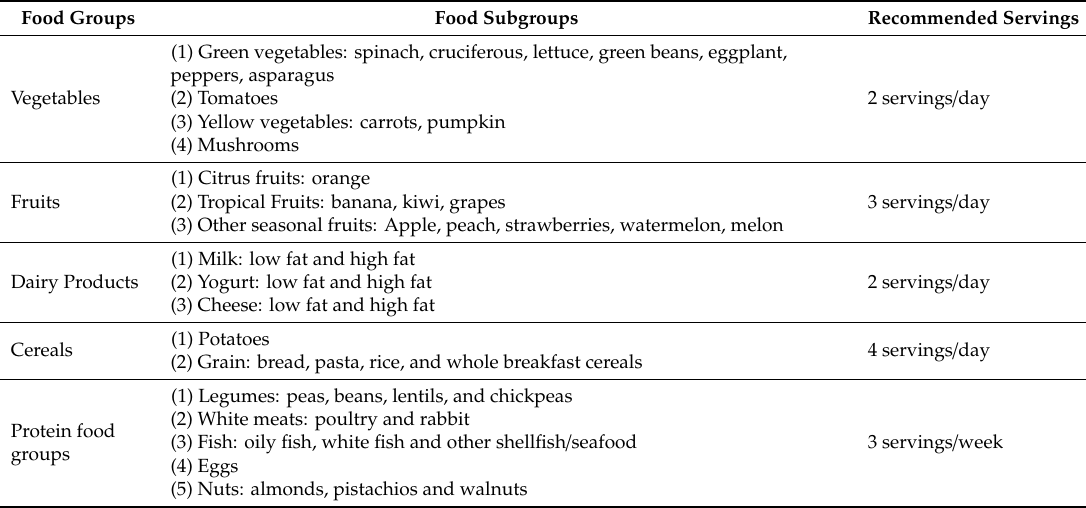
Table 1. Food groups and the recommended servings per day / week used in the dietary diversity score (DDS) according to the Spanish guidelines